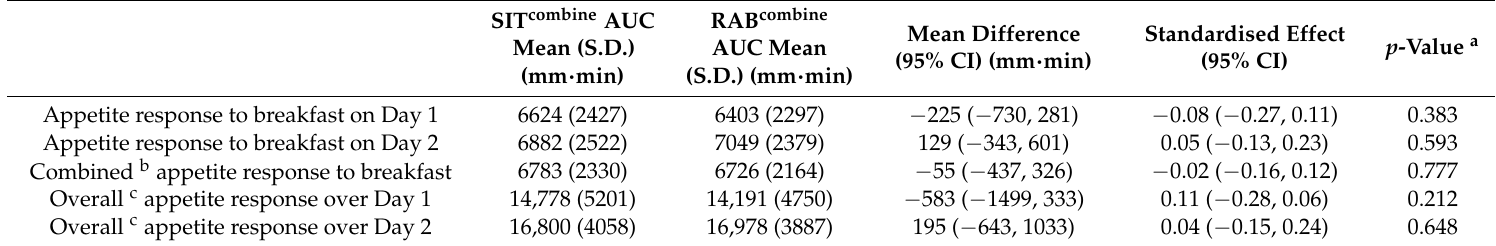
Table 3. Difference in postprandial appetite response between regular activity breaks (RAB combine ) and sedentary (SIT combine ) interventions ( n = 35). SIT combine AUC